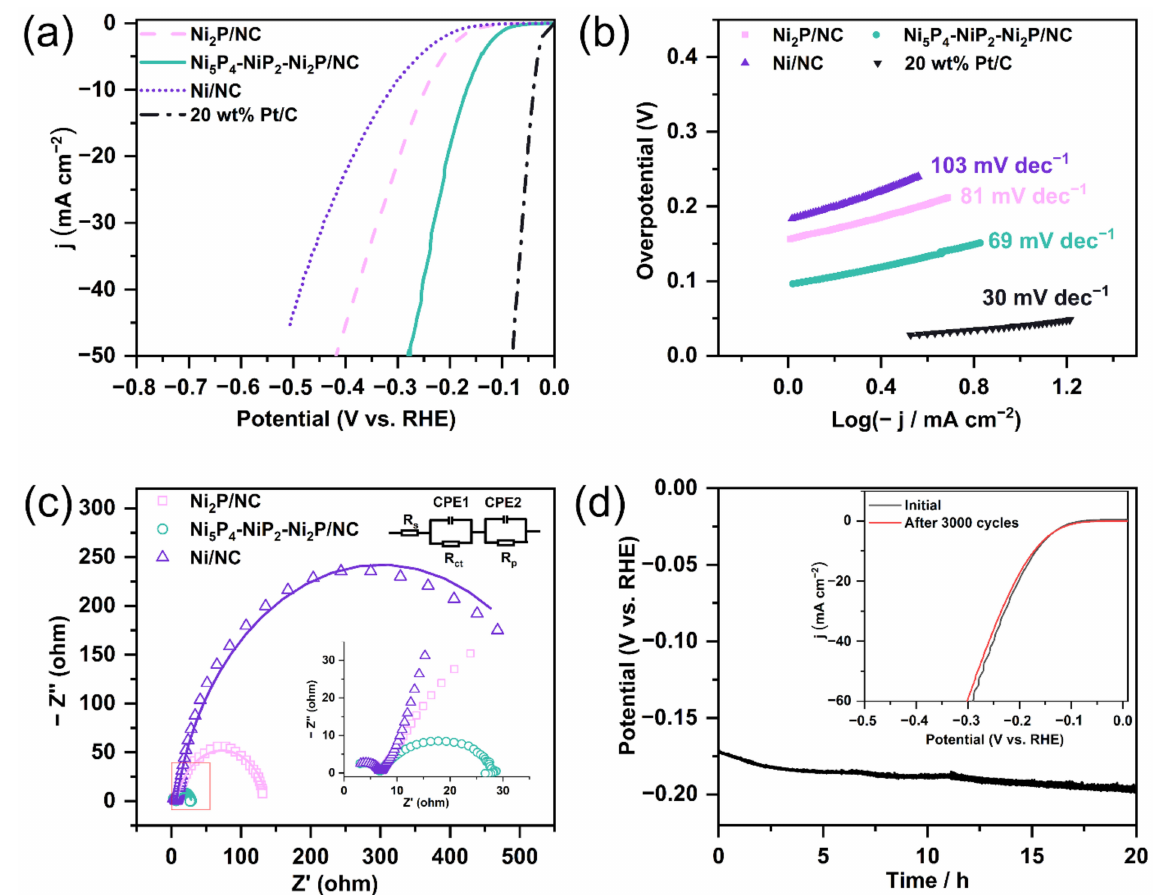
Figure 5. ( a ) Polarization curves of Ni/NC, Ni 2 P/NC, Ni 5 P 4 -NiP 2 -Ni 2 P/NC, and Pt/C in the 0.5 M H 2 SO 4 ; ( b ) the Tafel plots derived from Figure 5a; ( c ) Nyquist plots of Ni/NC, Ni 2 P/NC, and Ni 5 P 4 -NiP 2 -Ni 2 P/NC at the overpotential of 170 mV; ( d ) Chronopotentiometric curves of the Ni 5 P 4 -NiP 2 -Ni 2 P/NC catalyst with a constant current density of 10 mA cm − 2 for 70,000 s, insert is polarization curves of initial and after 3000 cycles of CV scans at 100 mV s − 1